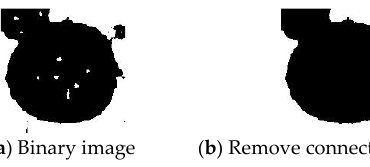
Figure 6. Background removal and edge detection.